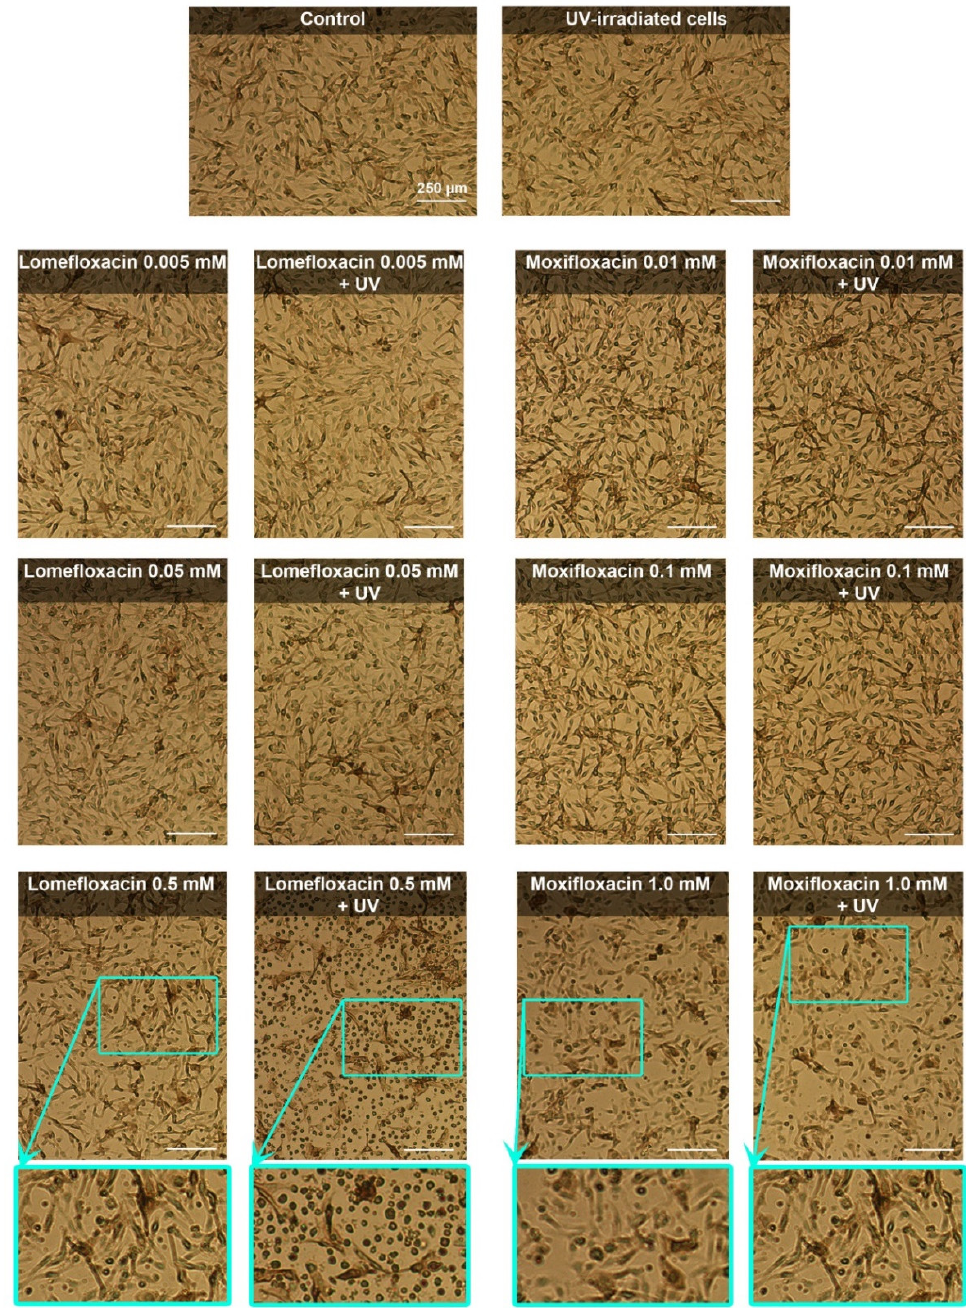
Figure 2. Cytotoxic and phototoxic effects of fluoroquinolones. The melanocytes were treated with lomefloxacin in concentrations of 0.005 mM, 0.05 mM, and 0.5 mM and moxifloxacin in concentrations 0.01 mM, 0.1 mM, and 1.0 mM. Scale bar = 250 µ m. Cell viability was determined by image cytometric analysis using viability and cell count assay. As shown in Figure 3, the exposure of melanocytes to both moxifloxacin and lomefloxacin led to the decrease in the number of viable (AO-positive, DAPI-negative) cells in a concentration-dependent manner. However, UVA radiation potentiated only the impact of lomefloxacin only on the viability of cells.